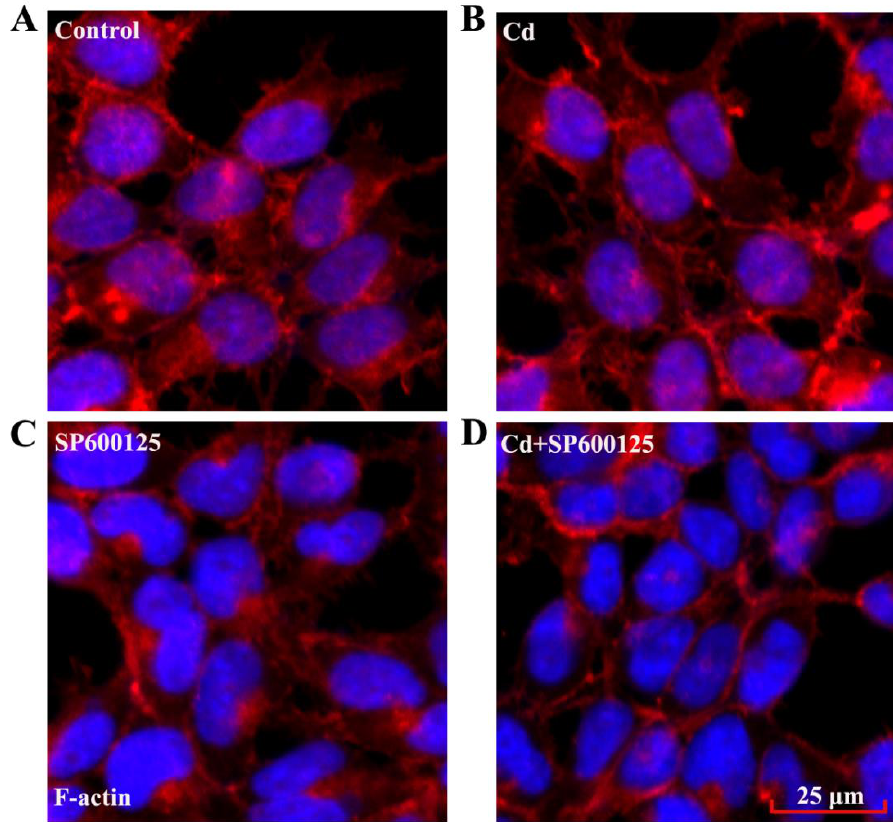
Figure 5. Effects of low dose Cd exposure on F-actin arrangement in HRMCs. Immunofluoresence staining of F-actin with Phalloidin–Tetramethylrhodamine B isothiocyanate in HRMCs monolayer treated with PBS (control) ( A ), 4 μM Cd for 24 h ( B ), 10 μM SP600125 for 24 h ( C ), 4 μM Cd and 10 μM SP600125 for 24 h ( D ).